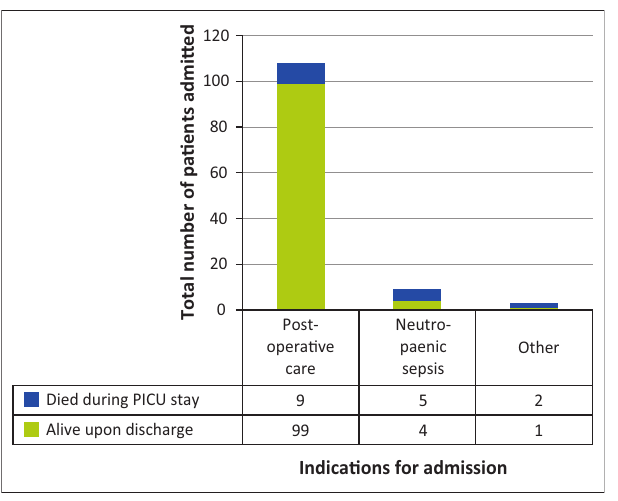
FIGURE 2: Primary diagnoses of oncology patients admitted to paediatric intensive care unit.